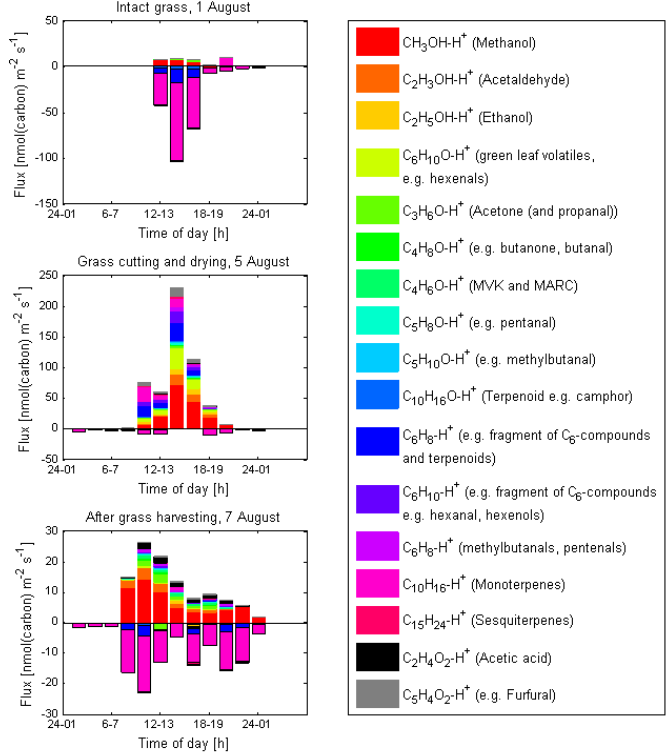
Fig. 5. The diurnal pattern of VOC carbon fluxes from intact grass (1 Aug), cut drying grass (5 Aug) and after grass harvesting (7 Aug) in two hour means of class-A Figure 5. The diurnal pattern of VOC carbon fluxes from intact grass (1 August), cut drying grass 2 (5 August) and after grass harvesting (7 August) in two hour means of class-A fluxes. 3